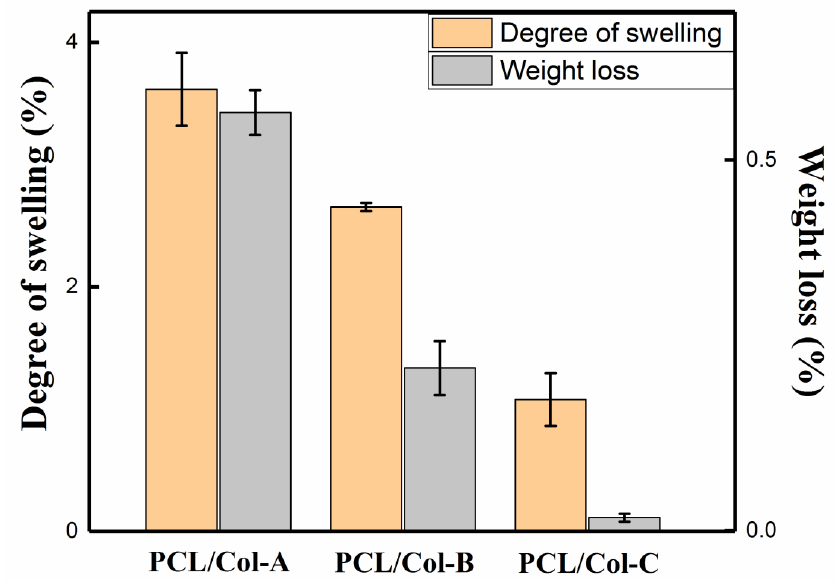
Figure 5. The degree of swelling and weight loss of the ART-loaded PCL/Col nanofibers with dif- ferent polymer ratios.